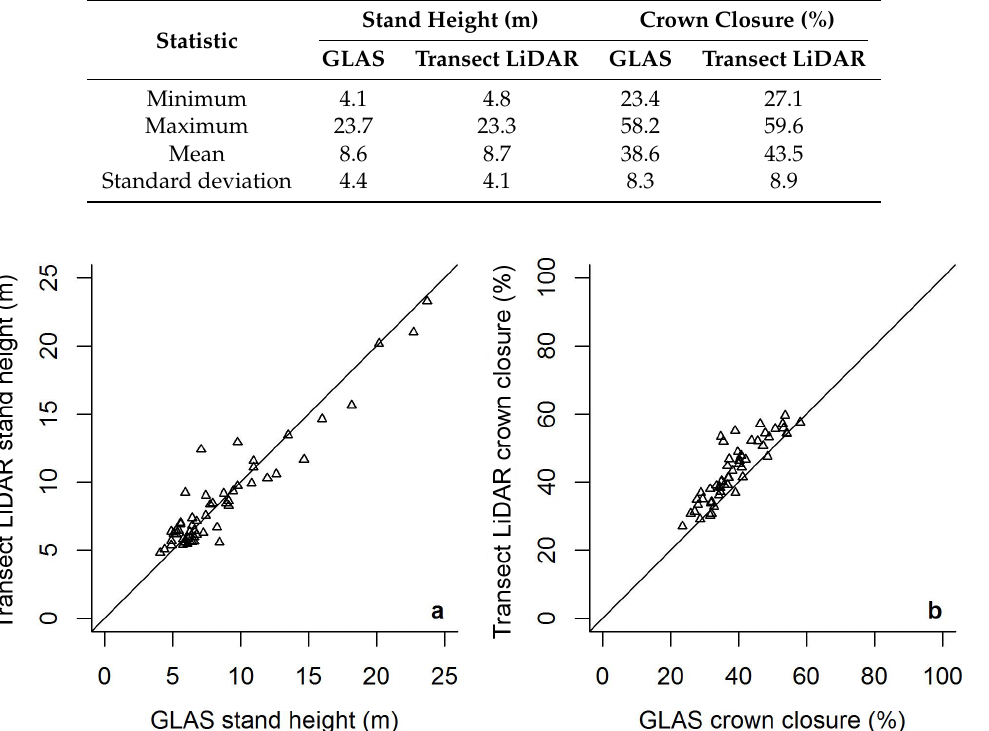
Table 5. Summary statistics indicating the similarity between Geoscience Laser Altimeter System (GLAS) and the independent, coincident transect LiDAR data.